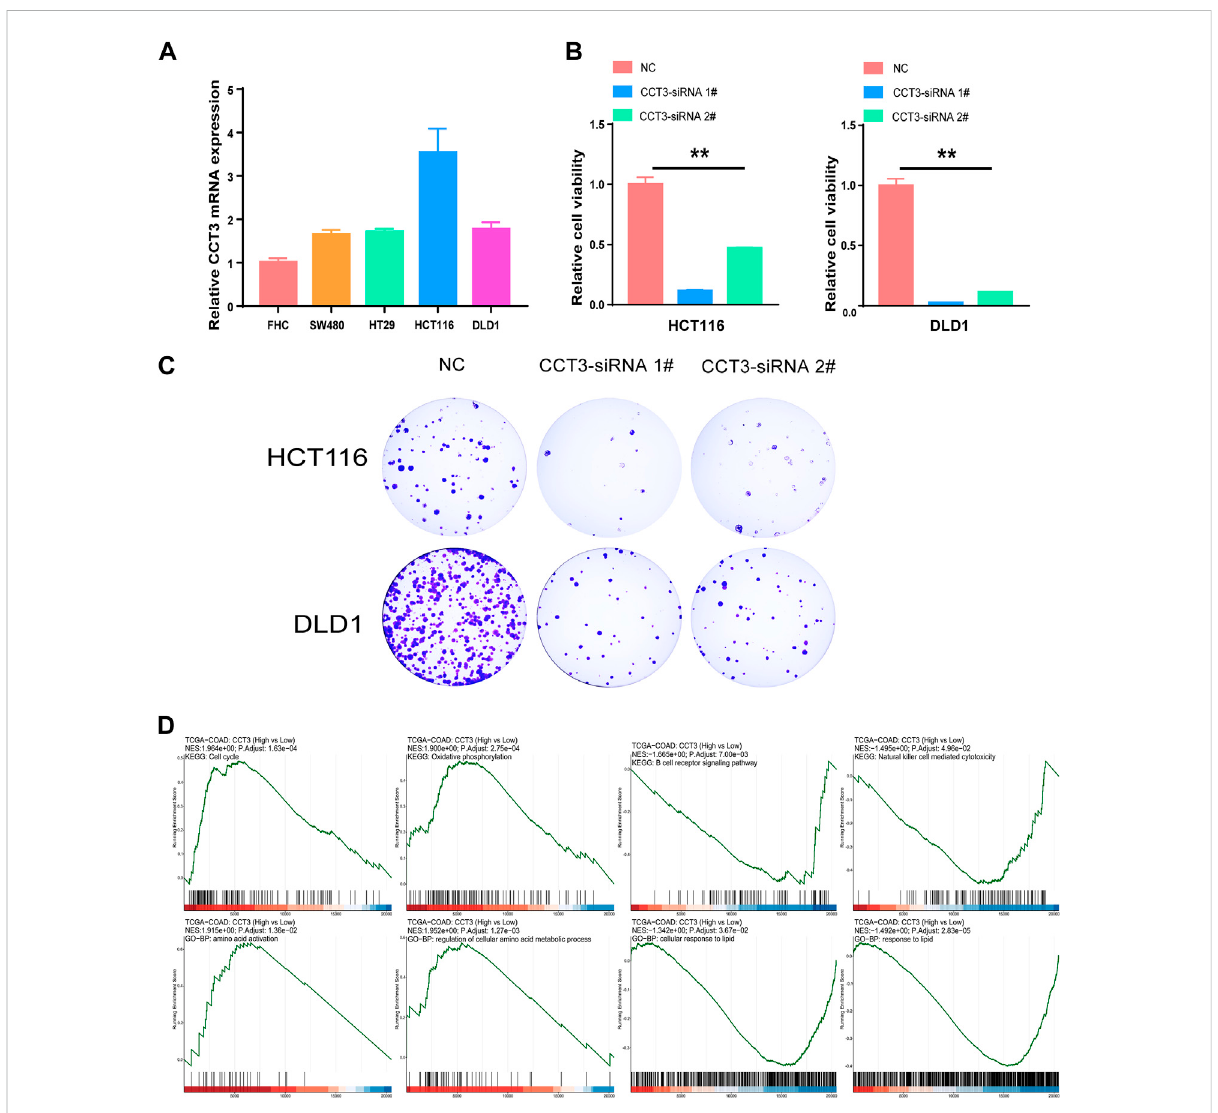
The effect of targeting CCT3 in COAD. (A) The expression levels of CCT3 in COAD cell lines were detected by qPCR assay. (B) The effect of CCT3knockdownonthecellviability wasdeterminedbyCCK-8assay. (C) Colonyformation assaywasconductedafter CCT3knockdown. (D) Gene set enrichment analysis (GSEA) for CCT3 in